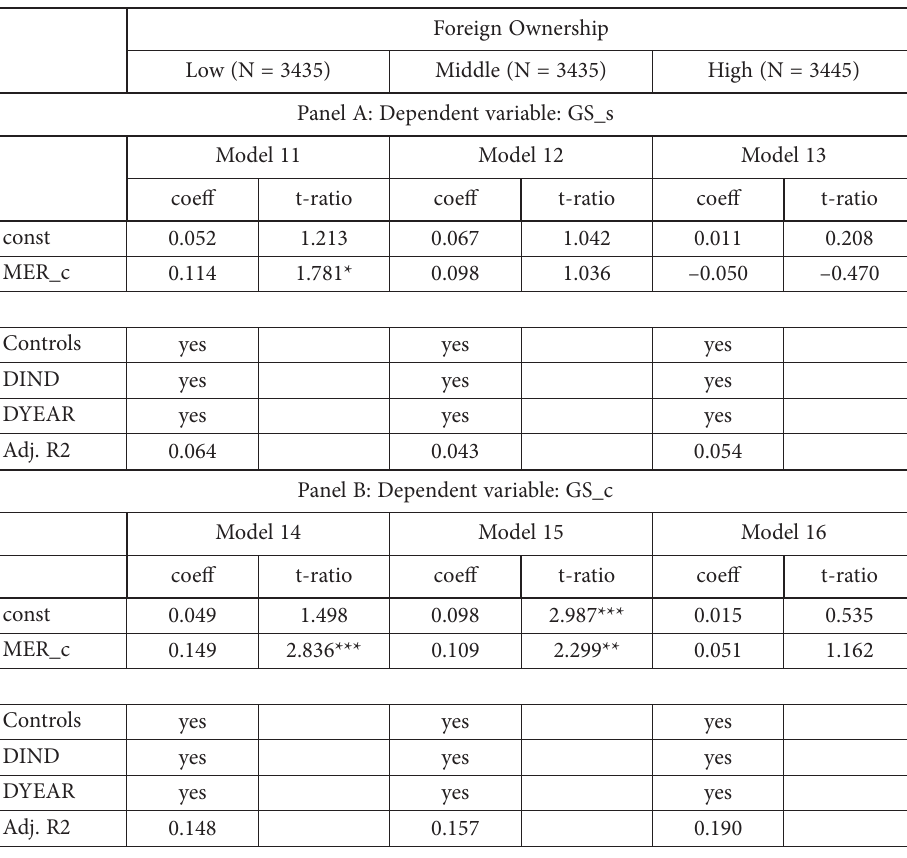
Table 6. Foreign ownership and growth of